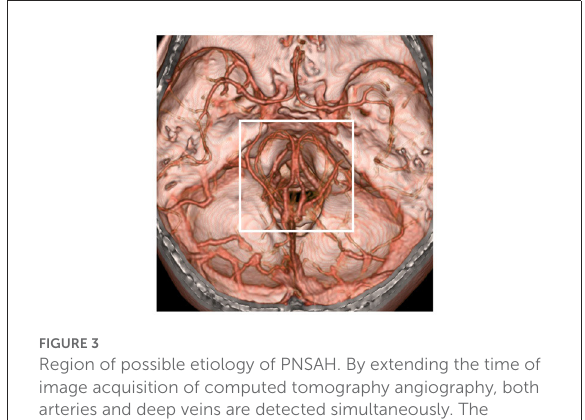
FIGURE3 Region of possible etiology of PNSAH. By extending the time of image acquisition of computed tomography angiography, both arteries and deep veins are detected simultaneously. The possible etiology of PNSAH should focus on the frame region. PNSAH, perimesencephalic non-aneurysmal subarachnoid